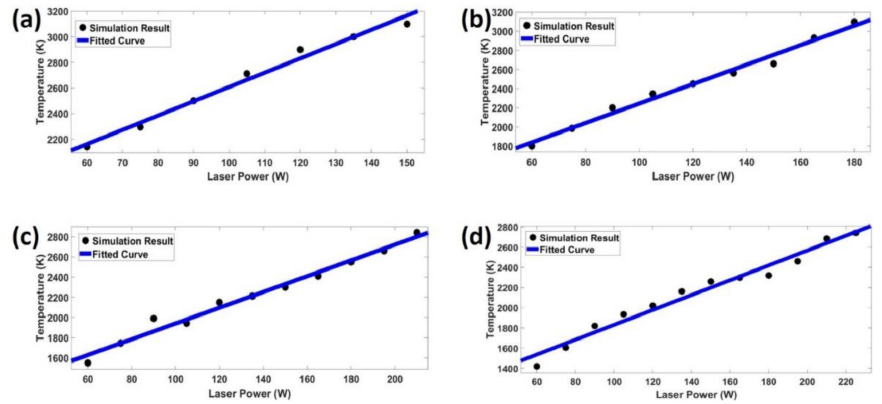
Figure 4. Simulation results and fitted curves of melt-pool temperature at various laser powers with a laser spot diameter of 80 µ m and scanning velocity of ( a ) 0.6 m/s, ( b ) 0.9 m/s, ( c ) 1.2 m/s, and ( d ) 1.4